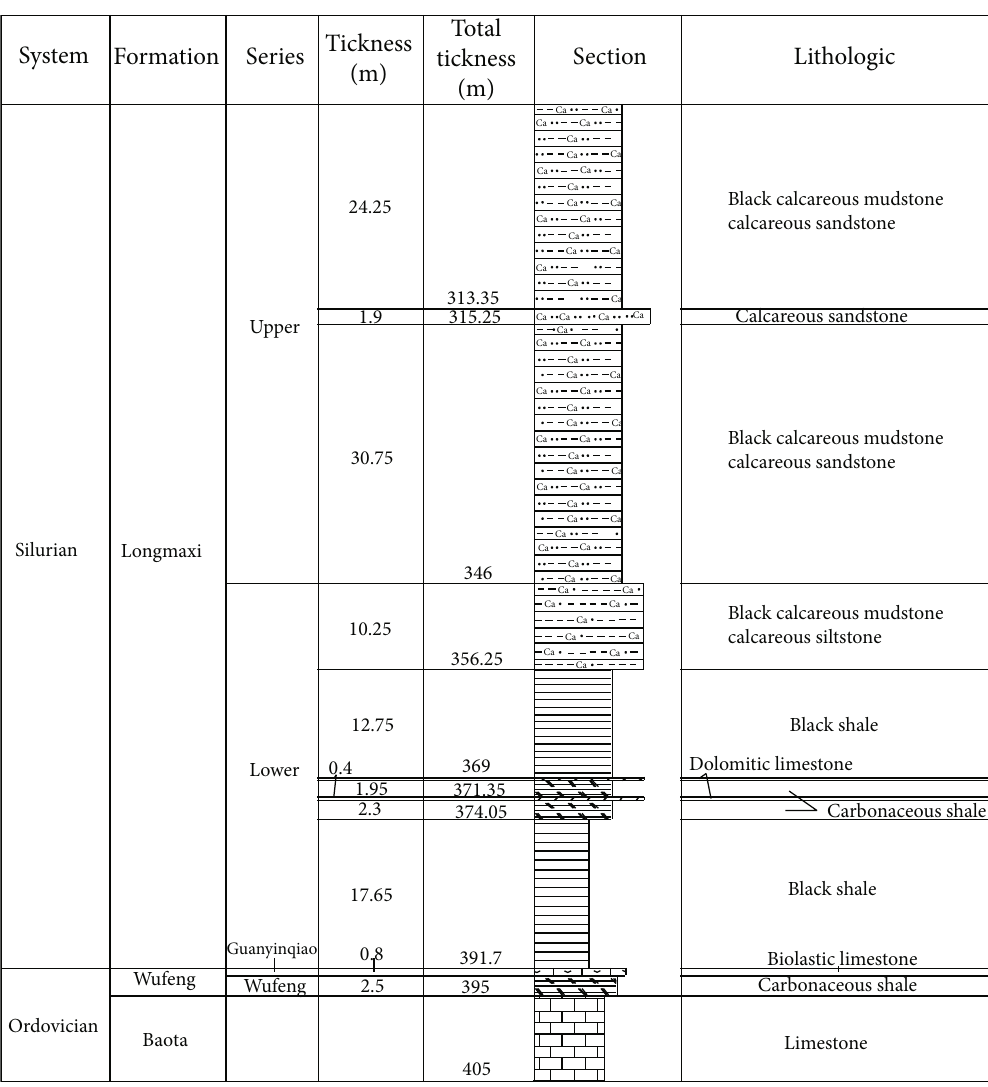
Figure 3: Stratigraphic histogram of the Wufeng-Longmaxi Formation (modi fi ed from Zhu et al.